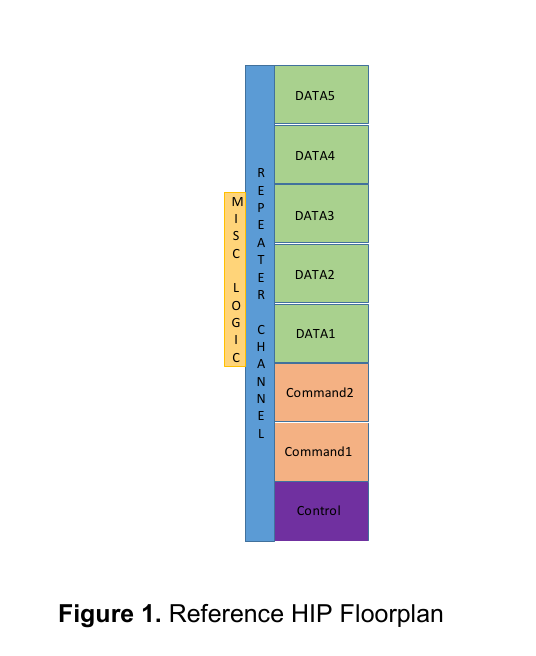
Table3: Degradation in flop drive strength if flop is driving 2 and 3 flops